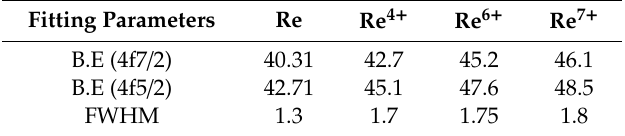
Table 2. The peak positions and fit paramters for Re 4f 7/2 and Re 4f 5/2 . Fitting Parameters